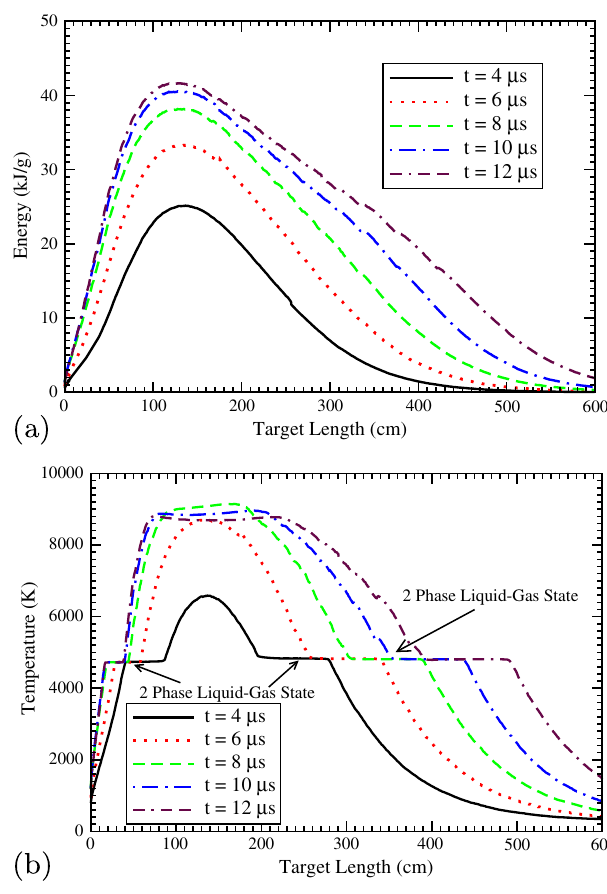
FIG. 8. (a) Specific energy deposition along the target axis at different times. (b) Temperature along the target axis at different